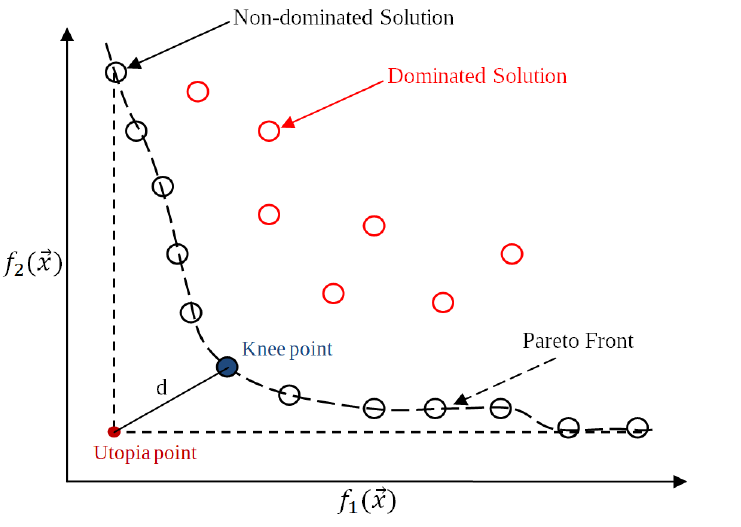
Figure 1. Pareto front of a multi-objective problem with two objective